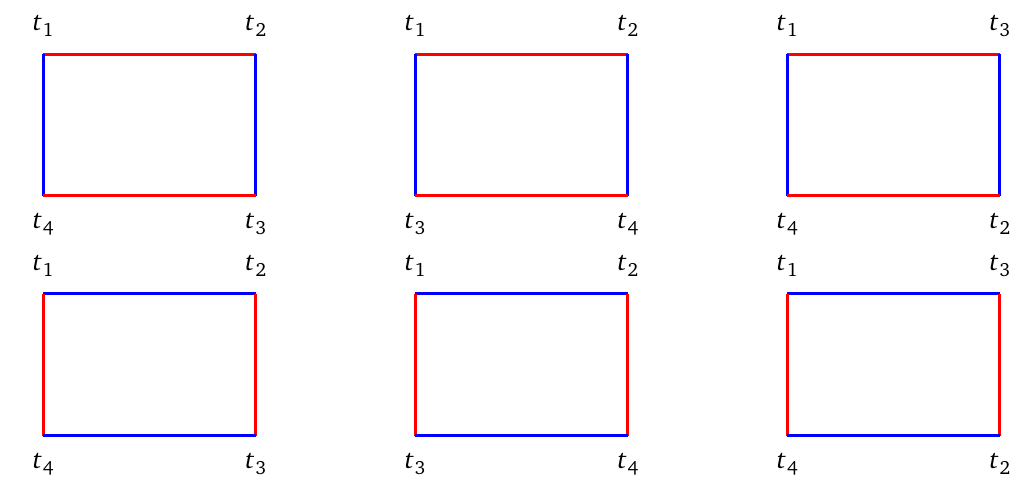
Figure 9: Feynman diagrams contributing to the 4-point